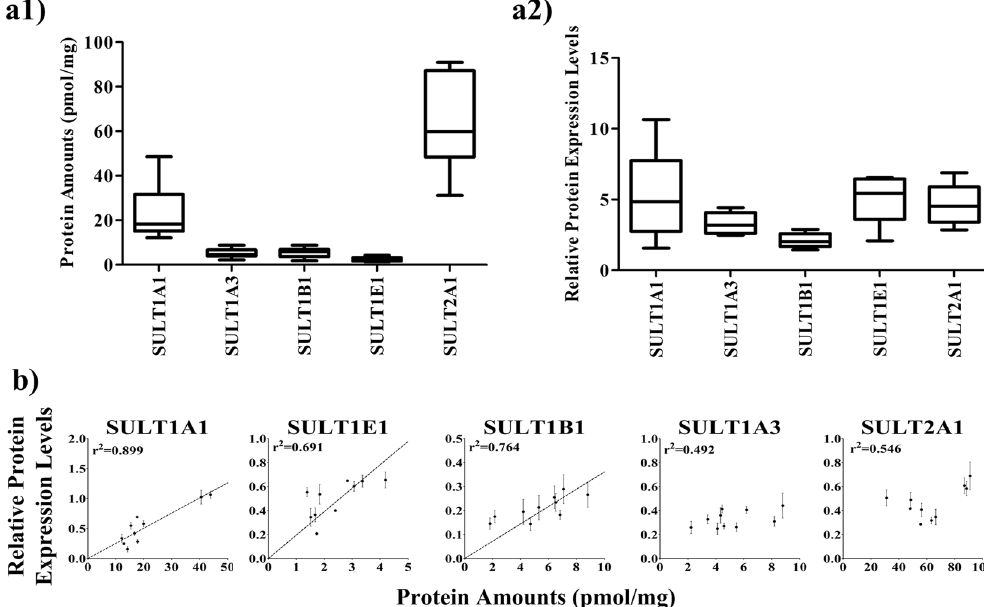
Figure 2. ( a1 , a2 ) Boxplots show the average protein amounts and relative protein expression levels of SULT1A1, SULT1A3, SULT1B1, SULT1E1, and SULT2A1 in the liver S9 samples from 10 healthy human donors, as determined by the MRM UHPLC-MS/MS method and Western blot analysis. ( b ) Correlation between the protein amounts and relative protein expression levels of SULT enzymes in hHLS9-individual. (SULT1A1, r 2 = 0.899; SULT1B1, r 2 = 0.764; SULT1E1, r 2 = 0.691; SULT1A3, r 2 = 0.492; SULT2A1, r 2 =